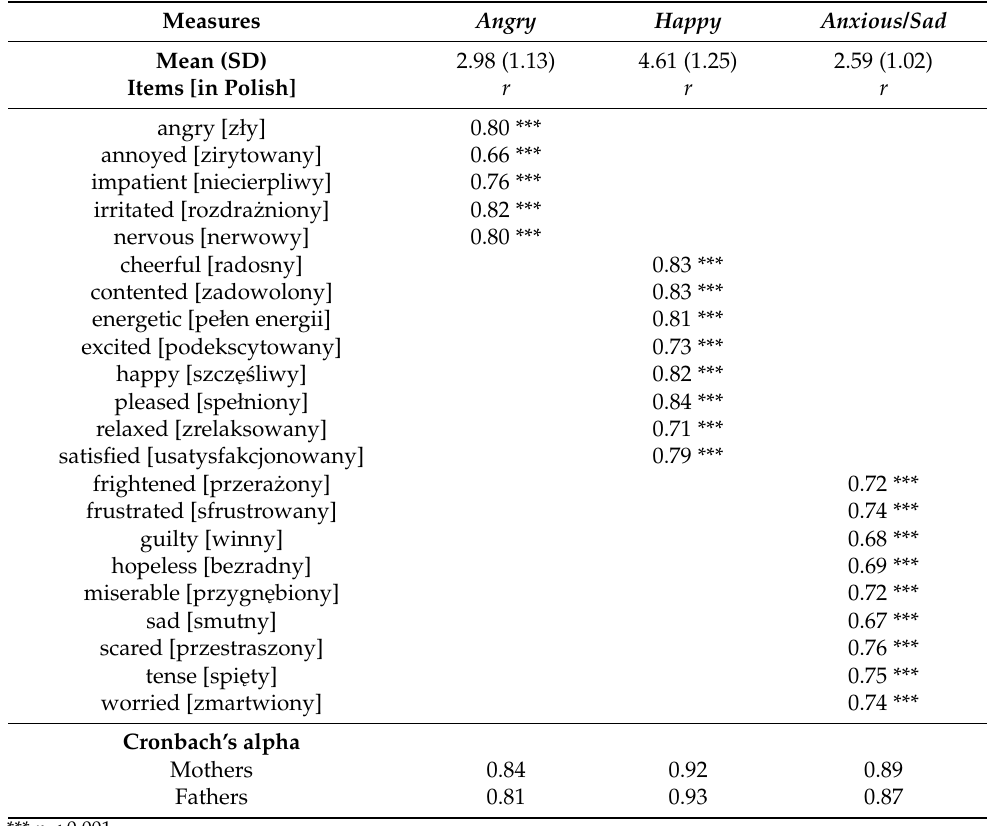
Table 4. Correlation coefficients of items with the general factor score and Cronbach’s α coefficients (N = 95).